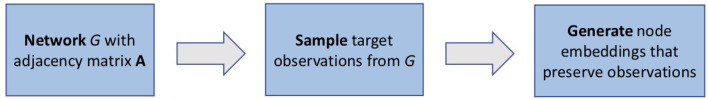
Building blocks of models with embedding look-up tables. There are two key components of these works: sampling and modeling. The primary distinction between different methods under this line relies on how to define the two components.